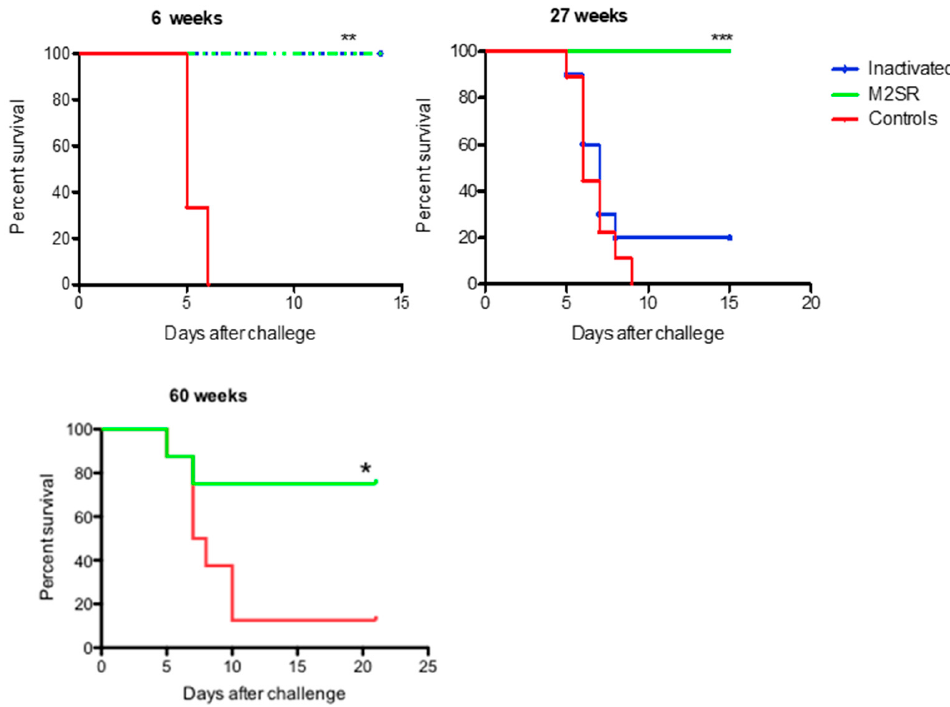
Figure 4. Duration of homosubtypic protection induced by single-replication and inactivated influenza viruses. Groups of 10 mice were vaccinated with M2SR-PR8 IN or inactivated PR8 IM as described in the Materials and Methods. Then, 25, 40, or 60 weeks later, the mice were challenged with 40 MLD 50 of live, wildtype PR8. Their survival was monitored for 15–21 days after challenge. Note: * significantly different from unvaccinated control; p < 0.05, ** p < 0.01, *** p < 0.001 (Mantel–Cox log rank test).